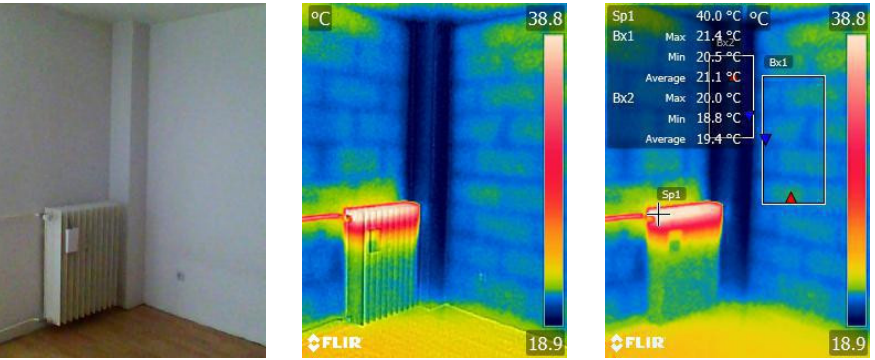
Figure 6. Thermal pattern of the outer wall.